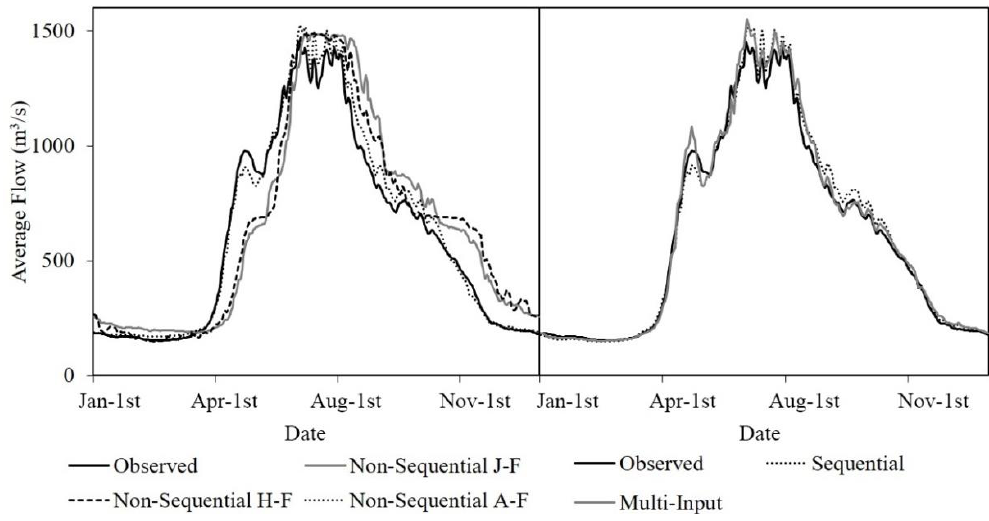
Figure 8. Hydrographs showing the results for the ANFIS models for Approach 2.